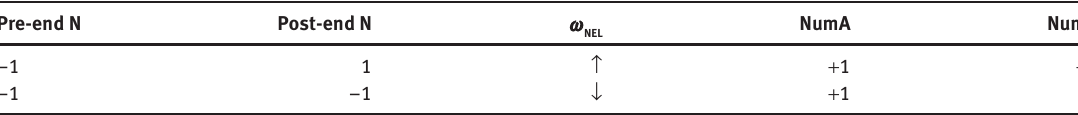
Table 2: Weight Alteration for NEL.